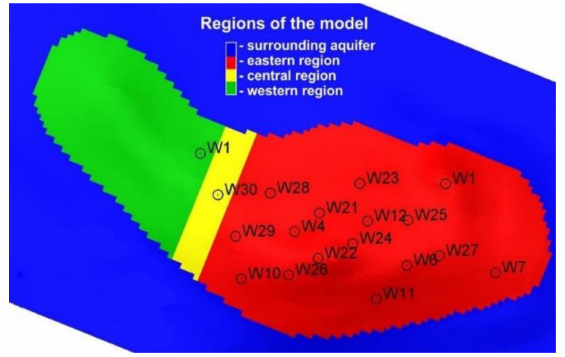
Figure 6. Top view of the reservoir simulation model including surrounding aquifer. Definitions of partially isolated reservoir regions—see Section 3 for